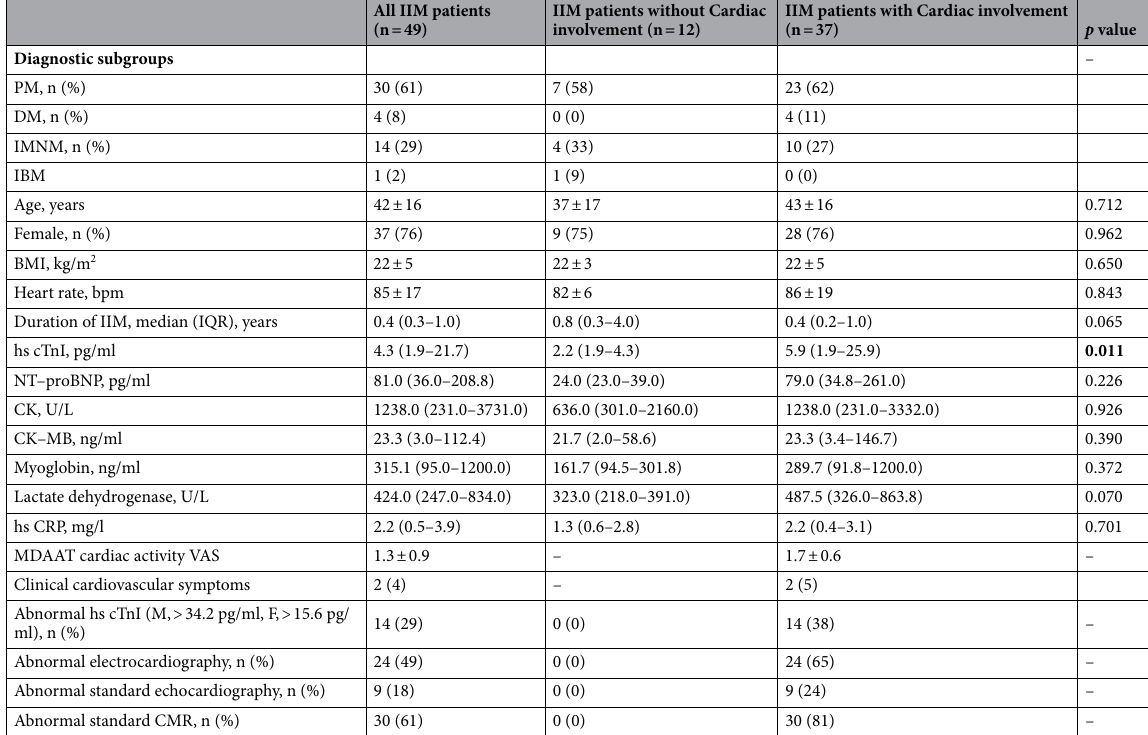
Table 1. Baseline characteristics of IIM patients. Data are expressed as N (%), mean ± standard deviation, or median (interquartile range). IIM, idiopathic inflammatory myopathy; PM, polymyositis; DM, dermatomyositis; IMNM, immune-mediated necrotizing myopathy; BMI, body mass index; SD, standard deviation; IQR, interquartile; hs cTnI, high-sensitive cardiac troponin I; NT-proBNP, N-terminal pro brain natriuretic peptide; CK, creatine kinase; hs CRP, high-sensitive C reactive protein; NSAID, nonsteroidal anti- inflammatory drug; MDAAT, the Myositis Disease Activity Assessment Tool; VAS, visual analogue; CMR, cardiac magnetic resonance. Bold value denote statistical significance ( p <